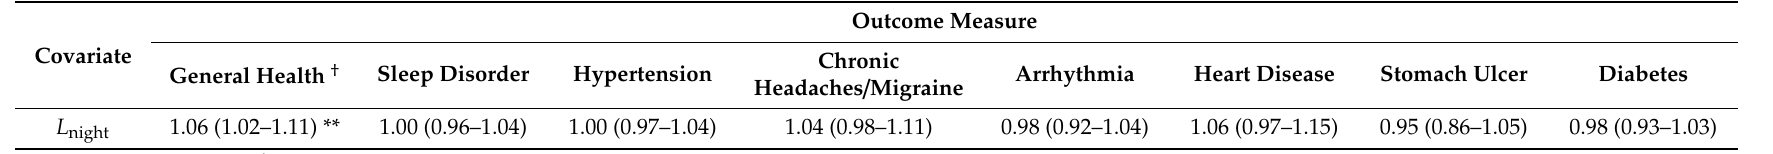
Table 6. Odds ratios and 95% confidence intervals from unadjusted logistic regression models for general health and diagnosis of di ff erent health outcomes.